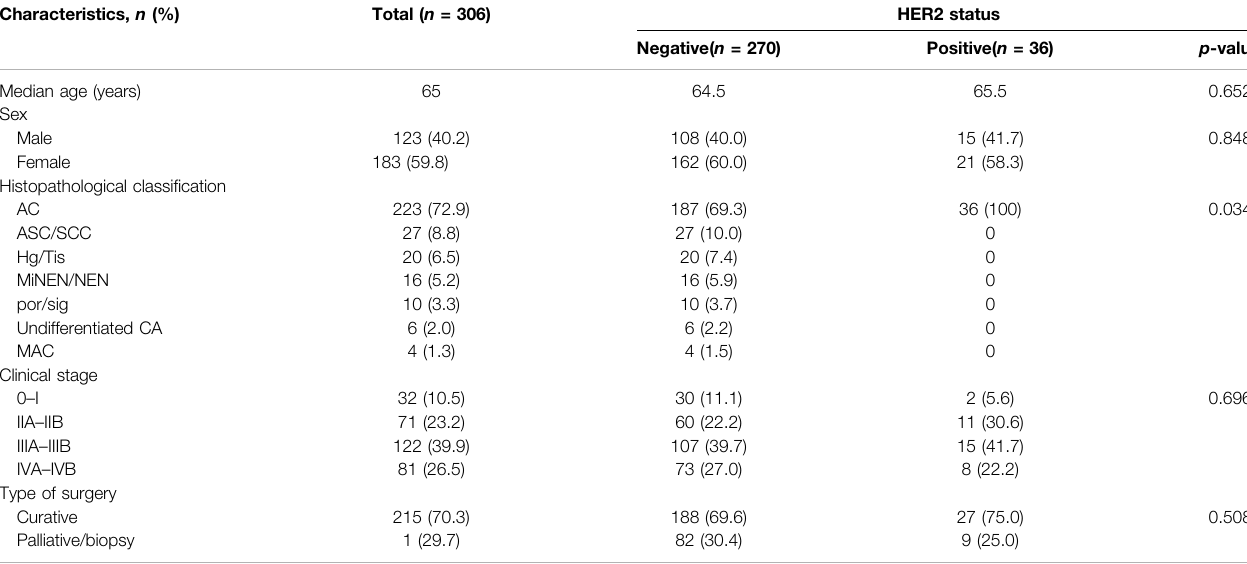
TABLE 2 | Comparison of the clinicopathological features between a HER2-positive and a HER2-negative status Characteristics, n (%)